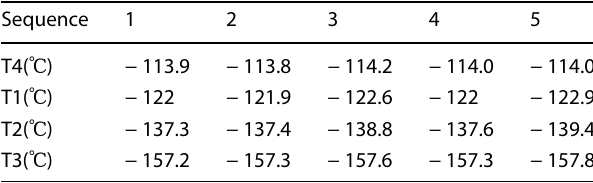
supplementation 2